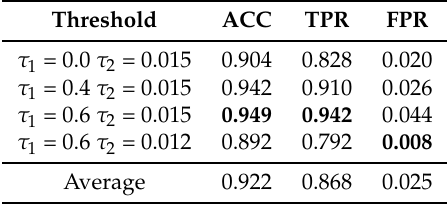
Table 2. Results of tampering detection with various thresholds τ 1 and τ 2 .